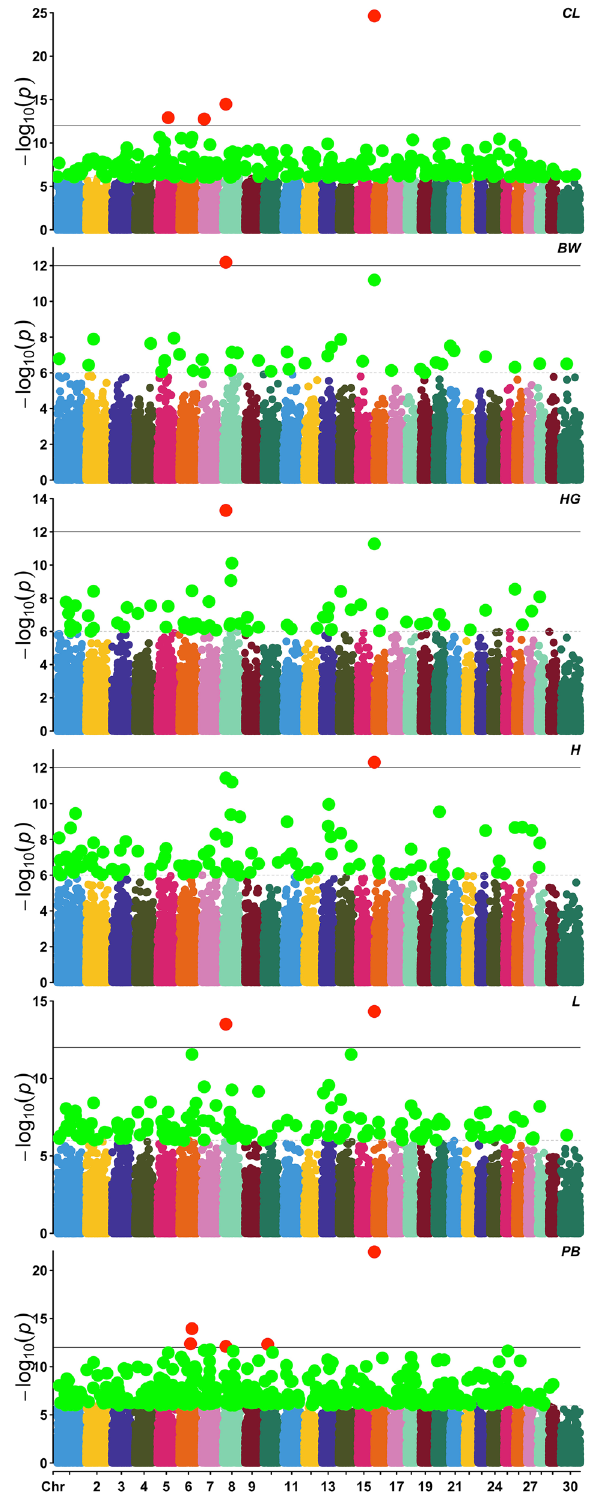
Figure 1. Genome wide Manhattan plot of the SNPs influencing CL = chest length, BW = body weight, HG = heart girth, H = height, L = body length, and PB = pubic bone length among Punjab goats generated using Caprine 50 K SNP Bead